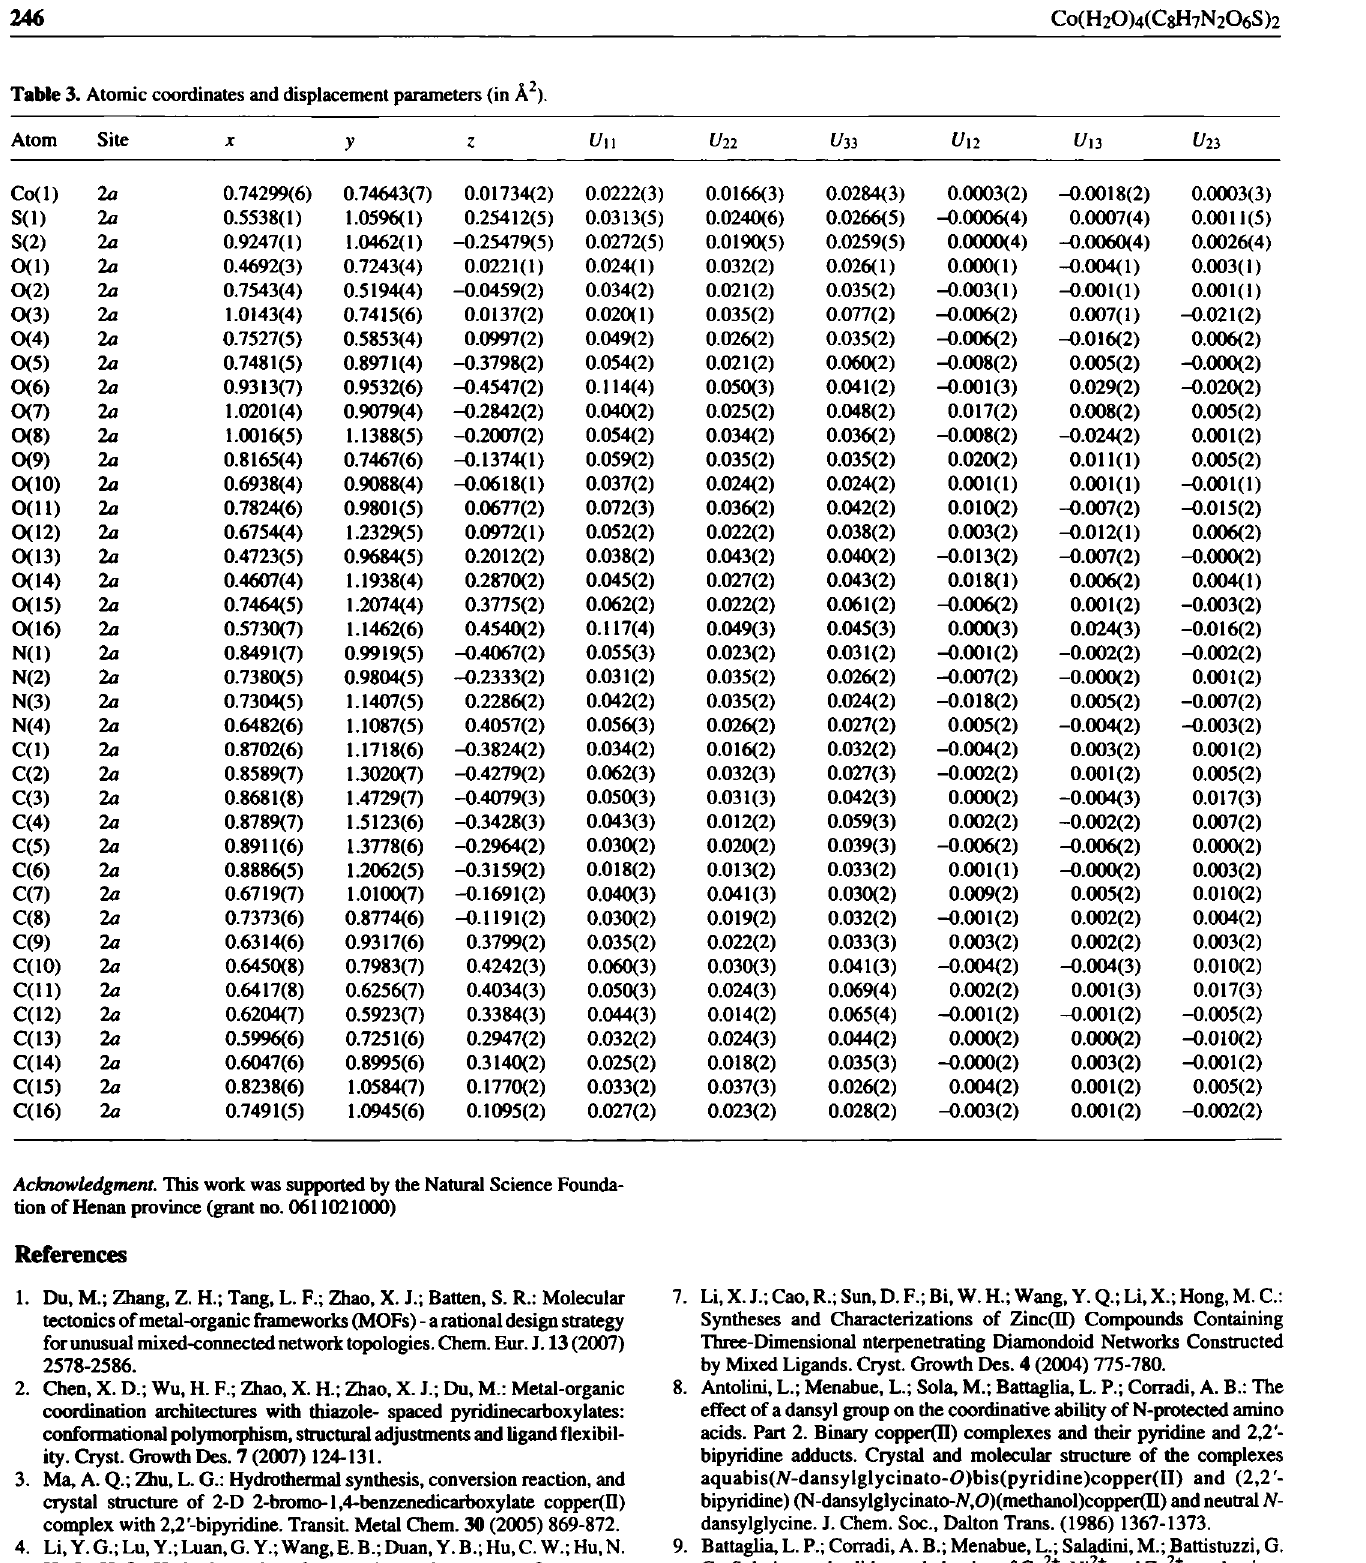
Table 3. Atomic coordinates and displacement parameters (in À 2